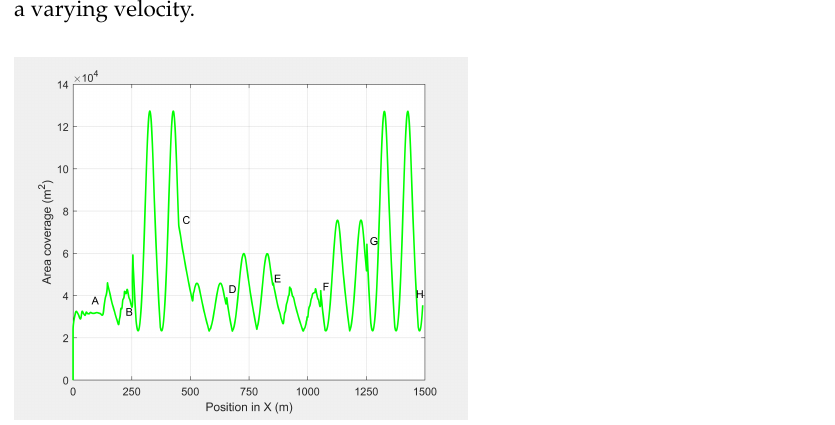
Figure 16. The UAV’s look-ahead coverage when following the MGV while moving at a varying velocity.